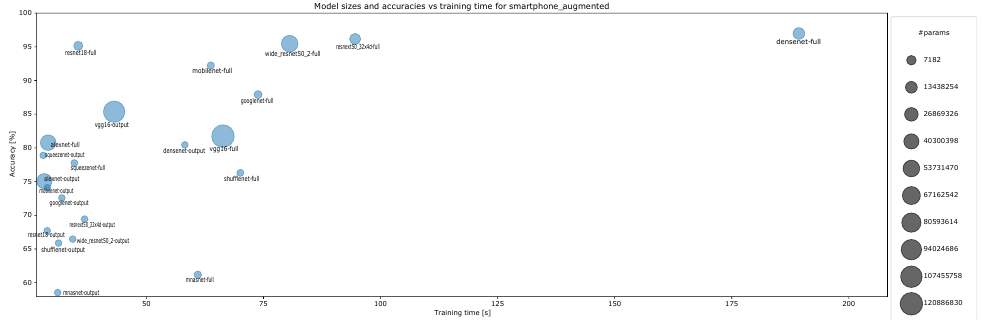
Figure A21. Accuracy vs, training time and model size for original smartphone data for one- episode training.